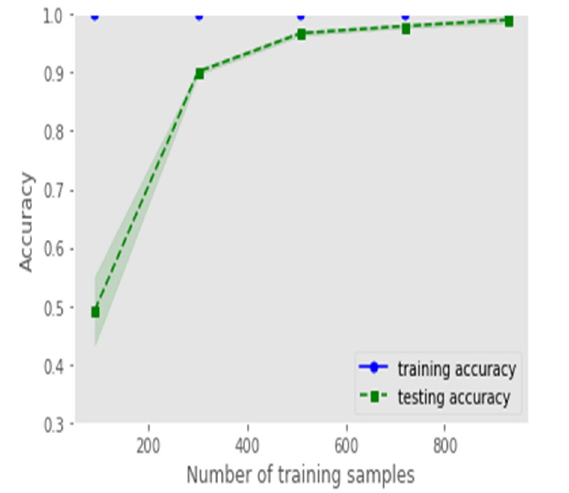
FIG. 2. RECOGNITION ACCURACY FOR FUSED FINGERPRINT AND SIGNATURE WITH DATA